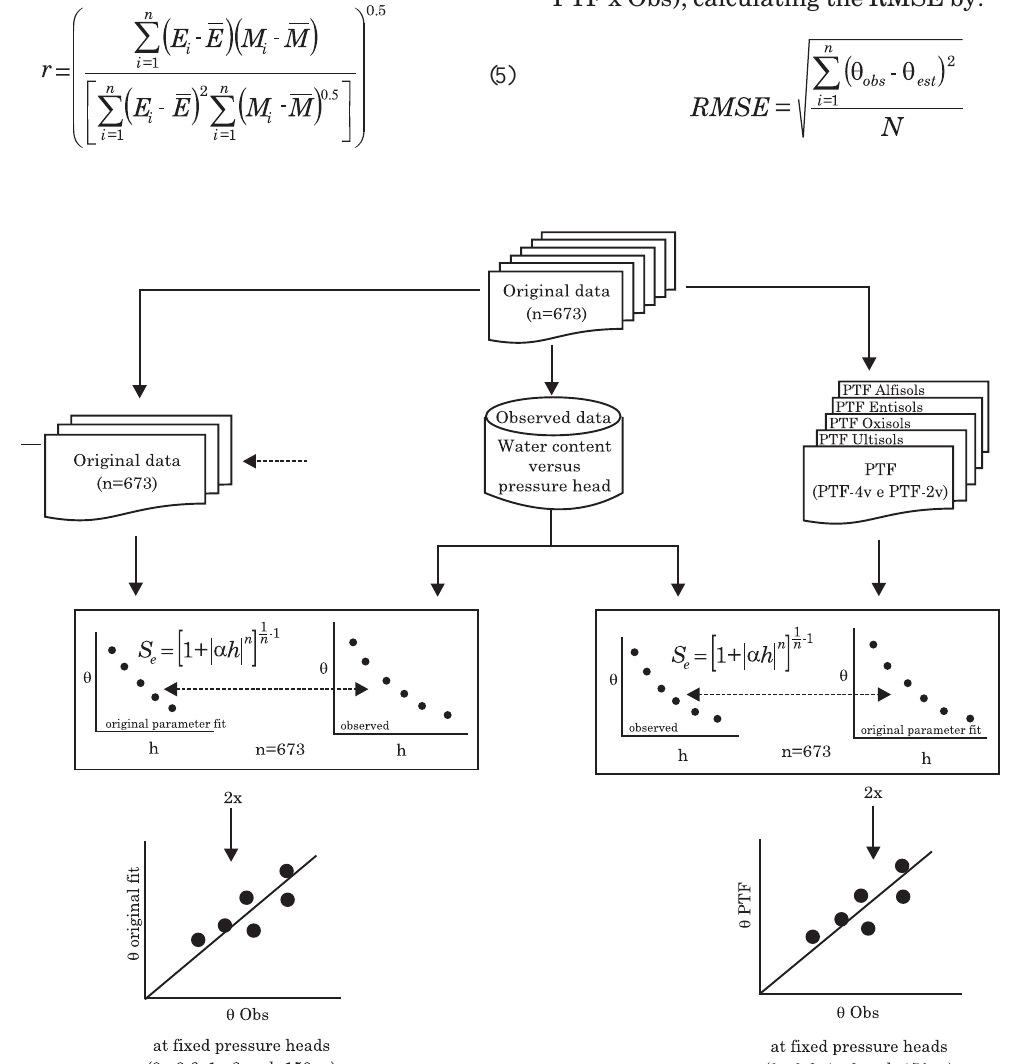
Figure 3. Schematic illustration of method to evaluate the pedotransfer functions as estimators of water content at specific pressure